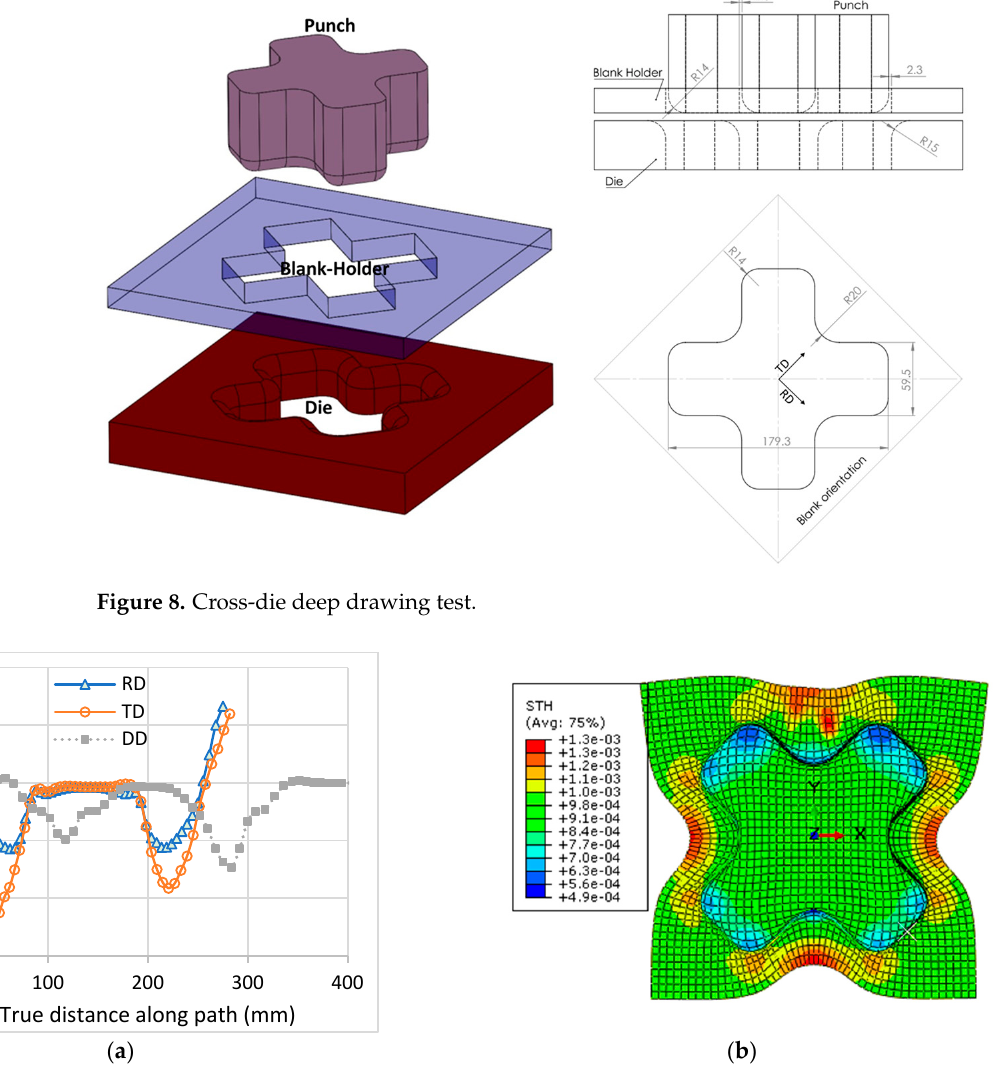
Figure 9. ( a ) Evolution of sheet thickness: along RD, TD, and DD; ( b ) distribution of the thickness in the simulated